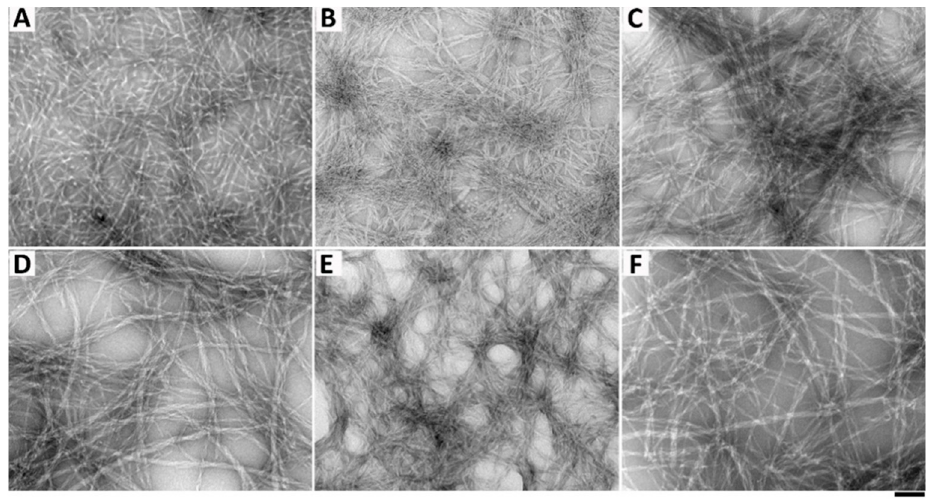
Figure 7. TEM images of 0.4 wt% NapFFKKFKLKL ( 2 ) ( A ) without or with the addition of ( B ) 0.5, ( C ) 1, ( D ) 2, ( E ) 3, and ( F ) 4 equiv. (molar ratio) AcDALDLTD ( 3 ). Scale bar is 100 nm.